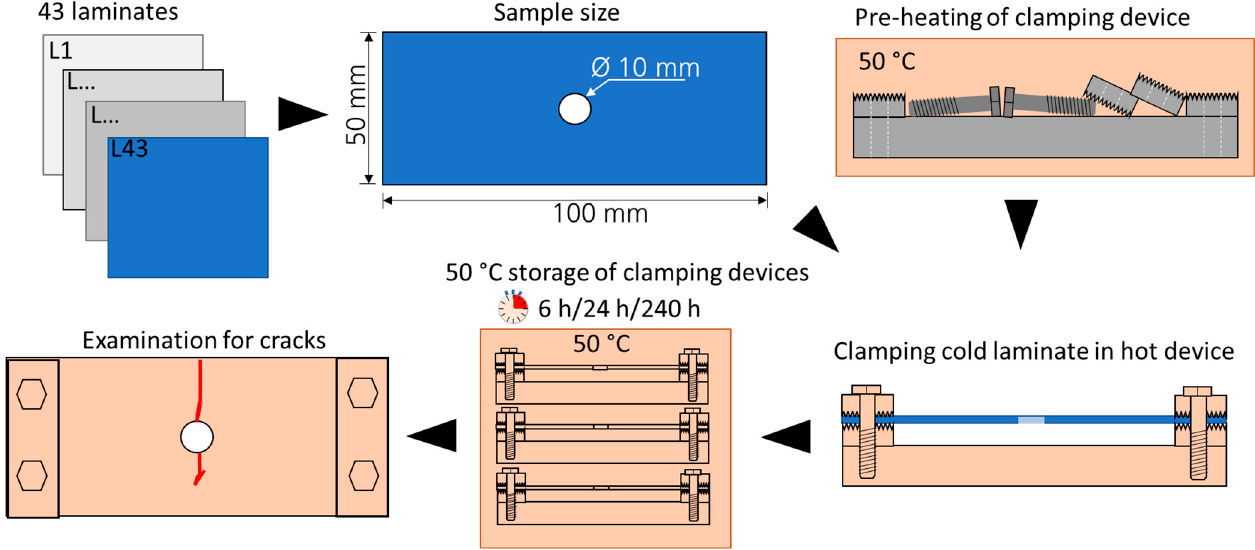
Figure 1. Schematic illustration of the EN 438-2 (23) procedure. The samples, 120 mm × 50 mm with a 10 mm hole in the centre, are clamped in the preheated devices and stored at 50 °C for 6 h. In the EN 438-2 setup (chapter 23 of the standard), the samples are loaded with tensile stress resulting from the laminate’s drying shrinkage counteracted by the laminate’s thermal expansion. Reported values for the swelling and shrinking of laminates are scarce.